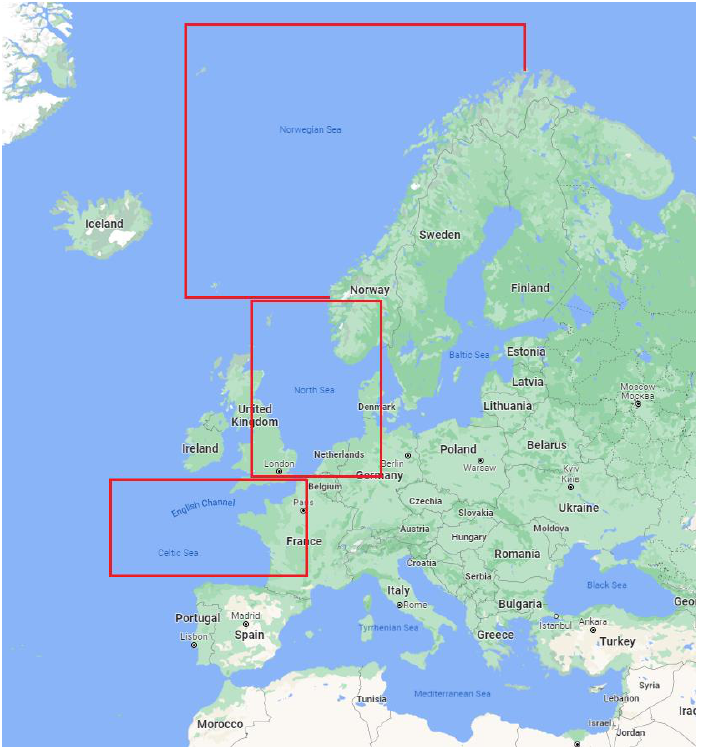
Figure 9. The geographical zones investigated in the study (figure processed from Google Maps).